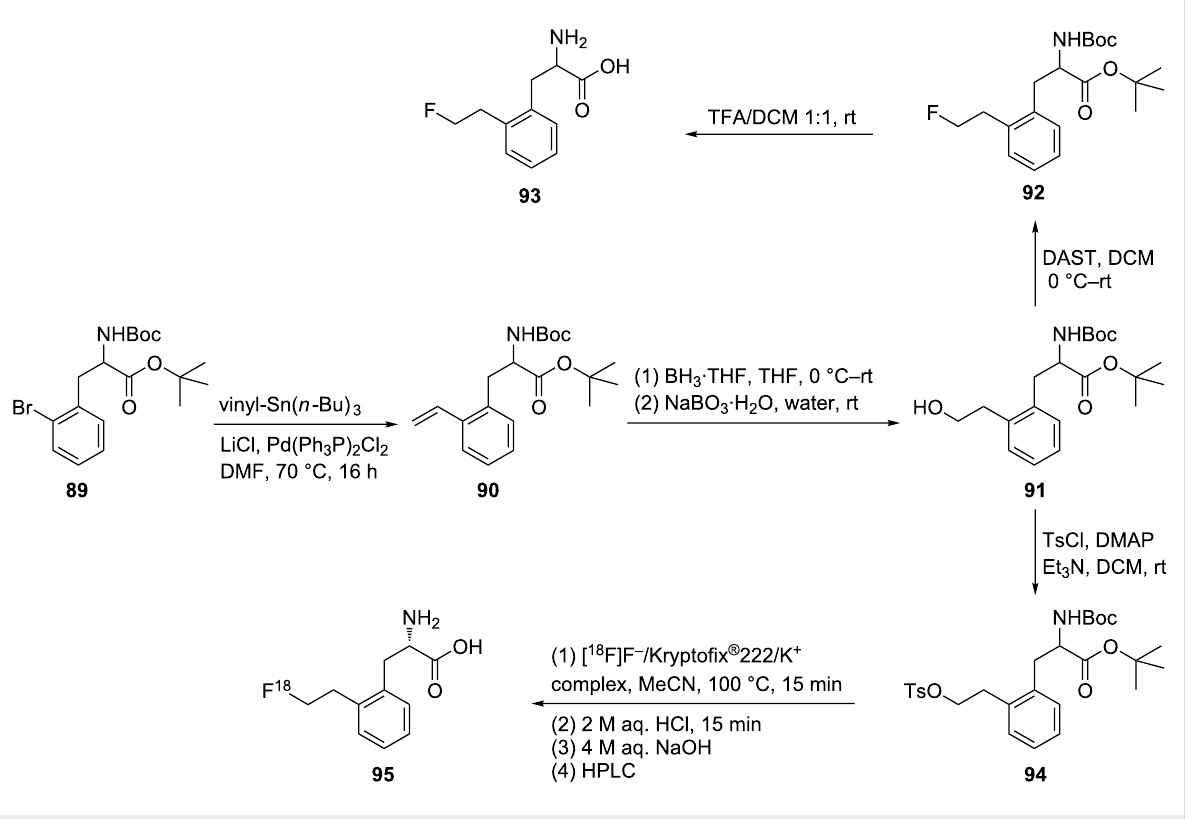
Scheme 21: Synthesis of 2-(2-fluoroethyl)phenylalanine derivatives 93 and 95